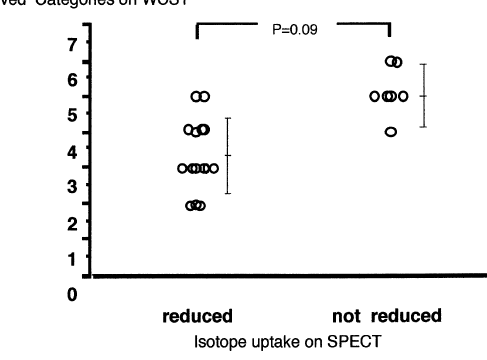
Fig. 5. The number of achieved categories on the Wisconsin Card Sorting Test and the reduction of isotope uptake There was a trend that the patients with the reduction in isotope uptake in the frontal lobe on SPECT achieved fewer categories on the Wisconsin Card Sorting Test. The vertical bars denote mean ± standard